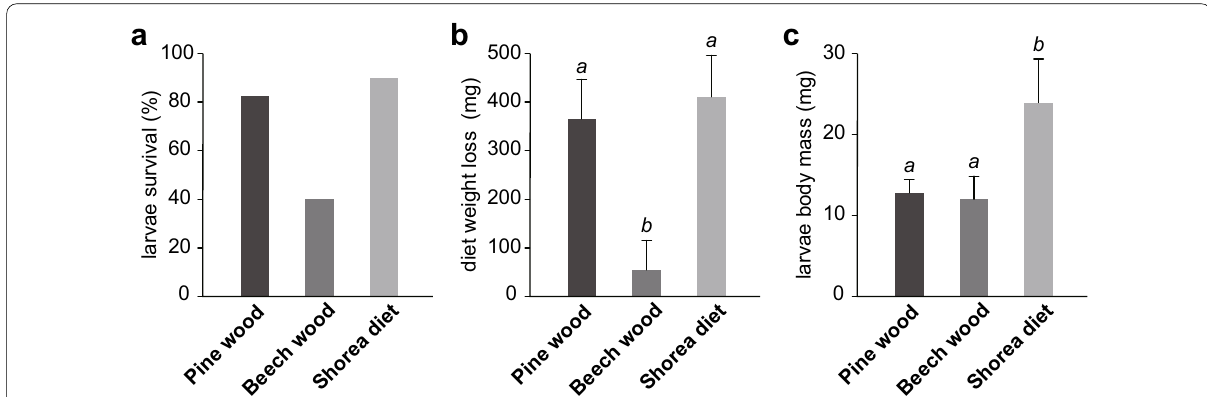
Fig. 2 Survival, feeding, and growth of N. hirtum larvae fed with different diets. Larvae survival ( a ), lignocellulose diet weight loss ( b ), and larvae body mass ( c ) of N. hirtum larvae after 5 months of feeding on Chinese red pine (softwood), Japanese beech (hardwood), or a Shorea (hardwood) artificial diet. Values in b and c are means SD ( n 20). Different letters indicate significant differences (one-way ANOVA with Tukey HSD test, ± = p <